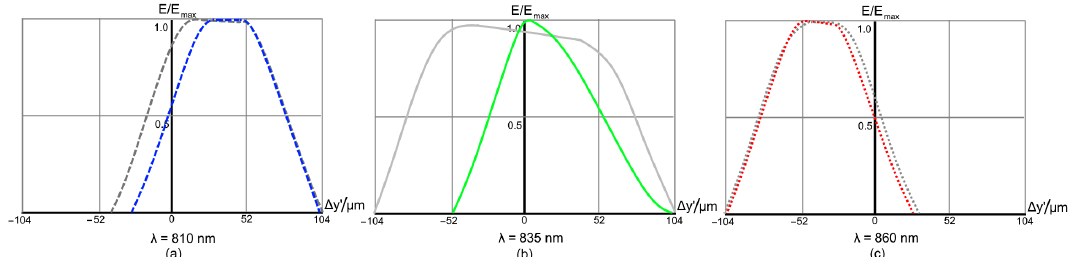
Figure 11. Instrument functions of the high-dispersion spectrograph Design C for a 50 µ m input fiber. The grey lines correspond to the design with flat detector.